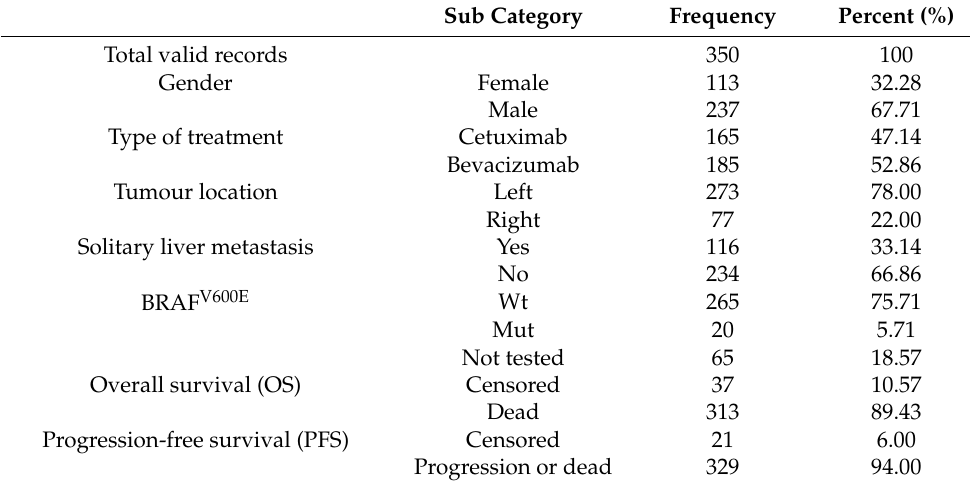
Table 1. Patient